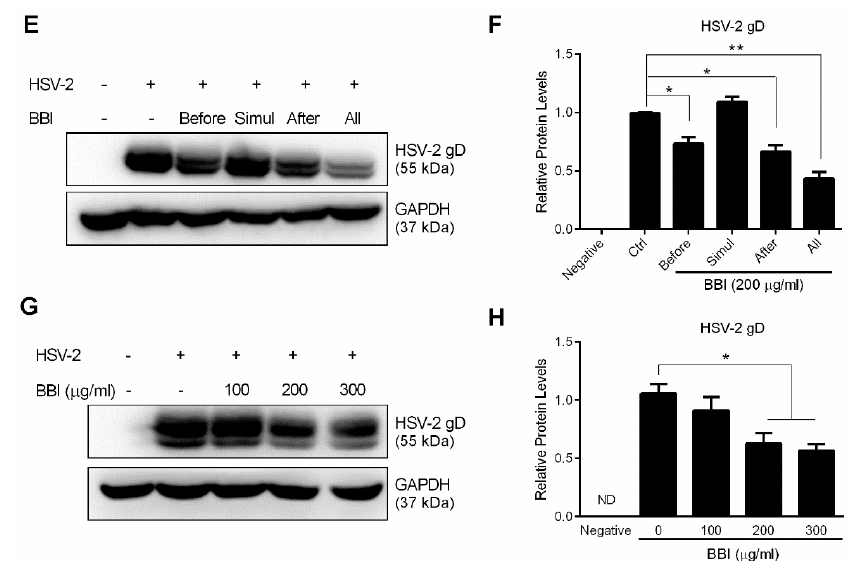
Figure 1. BBI inhibits HSV-2 infection. ( A , B ) End1/E6E7 cells were pretreated with BBI at indicated concentrations for 24 h, and then infected with HSV-2 (MOI of 0.001) for 2 h, cells were washed with PBS and maintained with or without BBI for 48 h. Total DNA extracted from ( A ) cells and ( B ) culture supernatant was measured by the real-time PCR using specific HSV-2 gD primers for HSV-2 gD quantification. ( C – E ) End1/E6E7 cells were pretreated with BBI (200 µ g/mL) for 24 h, then washed with PBS and infected with HSV-2, and then cultured without BBI (before); End1/E6E7 cells were treated with BBI and infected with HSV-2 simultaneously for 2 h, then washed with PBS and cultured without BBI (simul); End1/E6E7 cells were infected with HSV-2 for 2 h, then washed with PBS, cultured with BBI (after); BBI was maintained throughout the cell culture time period (all). At 48 h PI, ( C ) intracellular DNA, ( D ) extracellular DNA, and ( E ) total proteins were collected and analyzed by the real-time PCR or Western blot for HSV-2 gD gene expression. ( G ) End1/E6E7 cells were infected with HSV-2 for 2 h and then treated with BBI at the indicated concentrations, total cellular proteins were collected and subjected to Western blot. ( F , H ) Densitometry analysis of the blots shown in E and G was performed with ImageJ 1.44 software. Data shown were obtained as mean ± SD from three independent experiments (* p < 0.05, ** p < 0.01).